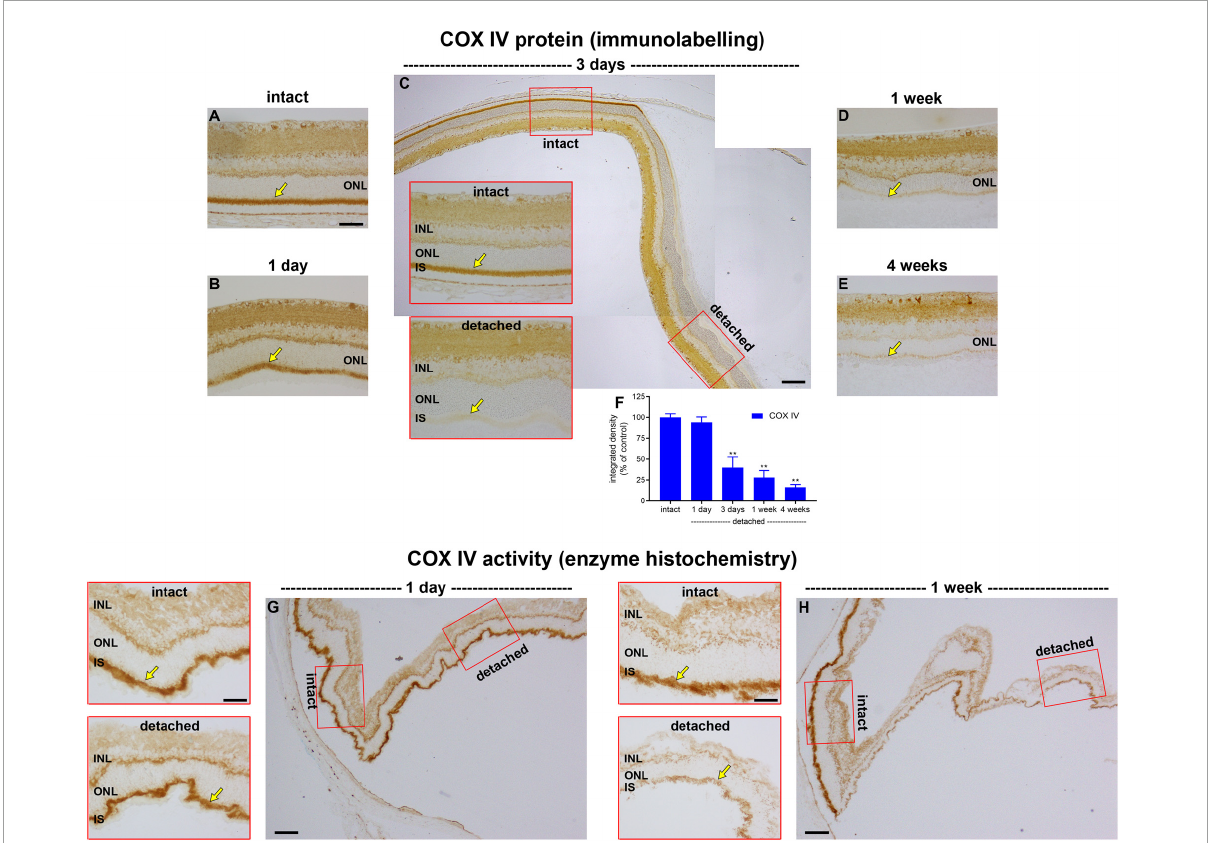
FIGURE2 Effect of retinal detachment on expression and activity of cytochrome C oxidase (COX IV), as evaluated by immunohistochemistry and enzyme histochemistry. (A–E) Representative images of COX IV immunolabelling in intact retina, and at 1 day, 3 days, 1 week, and 4 weeks after detachment. Arrows demarcate inner segments (IS). (F) Quantification of COX IV immunoreactivity associated with IS at 1 day, 3 days, 1 week, and 4 weeks after retinal detachment. Values, shown as % of the intact group, represent mean ± SEM. ** P < 0.01 by one-way ANOVA followed by post-hoc Dunnett’s multiple comparisons test (intact vs. detached). (G,H) Representative images of COX IV activity as evaluated by enzyme histochemistry in intact retina and at 1 day and 1 week after detachment. Scale bars: (A–C) (insets), (D,E,G) (insets), and (H) (insets) = 60 µ m; (C,G,H) (overviews) = 150 µ m. INL, inner nuclear layer; ONL, outer nuclear